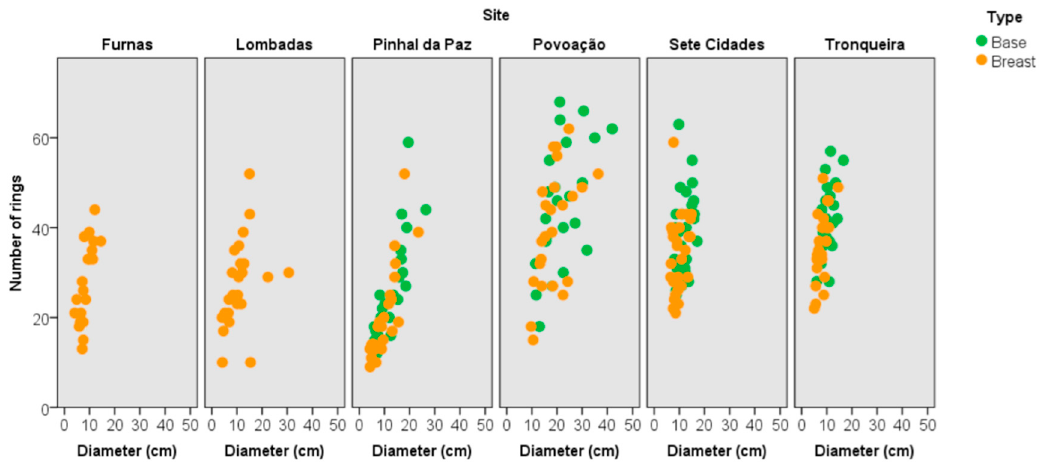
Figure 8. Scatter plots representing the relationship between estimated tree age and trunk diameter at base and at breast height, for six stands of L. azorica (Seub.) Franco in São Miguel Island. Table 2. Selected allometric equations relating tree age and dendrometric parameters tested for 147 L. azorica (Seub.) Franco trees sampled at breast height (BH), for 97 L. azorica trees sampled at base (Base), and for each stand of L. azorica in São Miguel Island. Allometric models: * [54]; ** [2]; *** Current study. Regression model equation (see Tables S1–S7); Stand code (see Table 1). N (number of samples). Plot # (see Figure 9). Adjusted determination coefficient (Adj R 2 ); Akaike Information Criterion (AIC); Root Mean Square Error (RMSE); Mean Relative Error (MRE); Correction Factor (CF); Diameter (D); Tree Height (H); Basal Area (BA). This is a selection of the best models. See Tables S1–S7 for the full set of tested